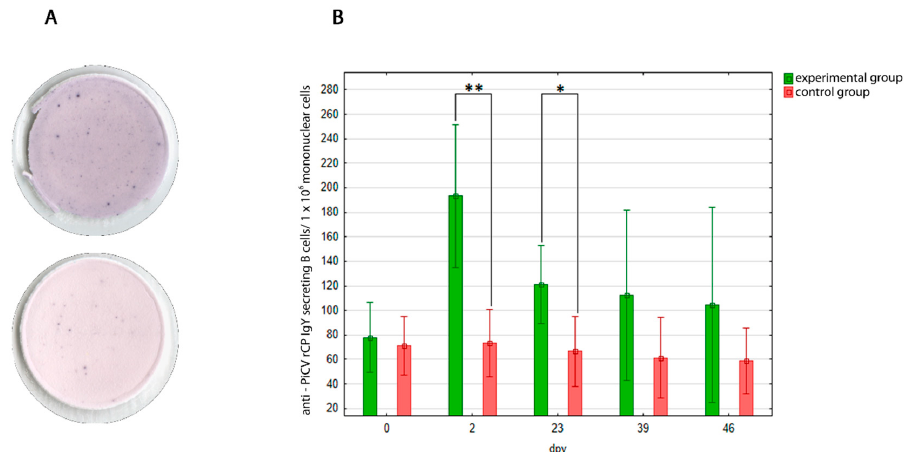
Figure 2. ( A ) Comparison of two representative samples of PiCV rCP immunized pigeons